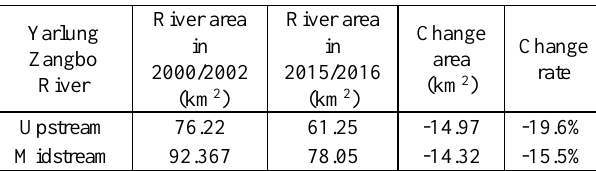
Table 3. River area of upstream and midstream of